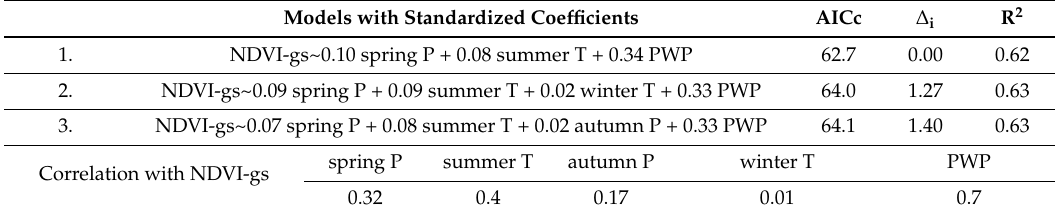
Table 1. Regression coefficients of NDVI-gs models with seasonal climate variables from 1982 to 2011 as predictors. AICc refers to Akaike’s information criterion with a sample size correction (see Equation (2)).